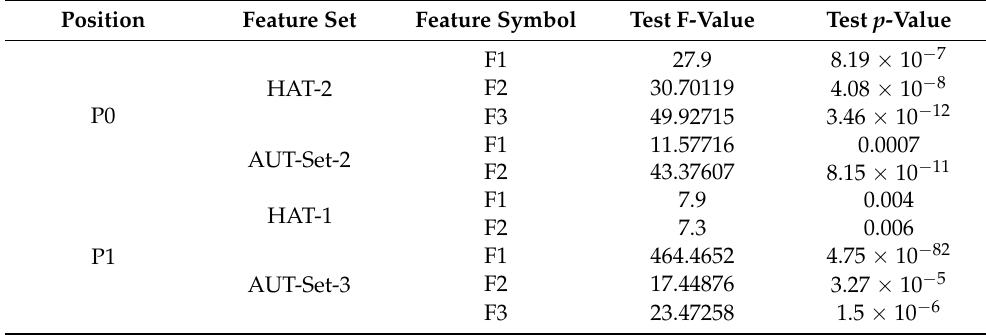
Table 12. Outcomes of ANOVA Test of Autoencoder-based features’ significance in predicting the SWH using P0 and P1